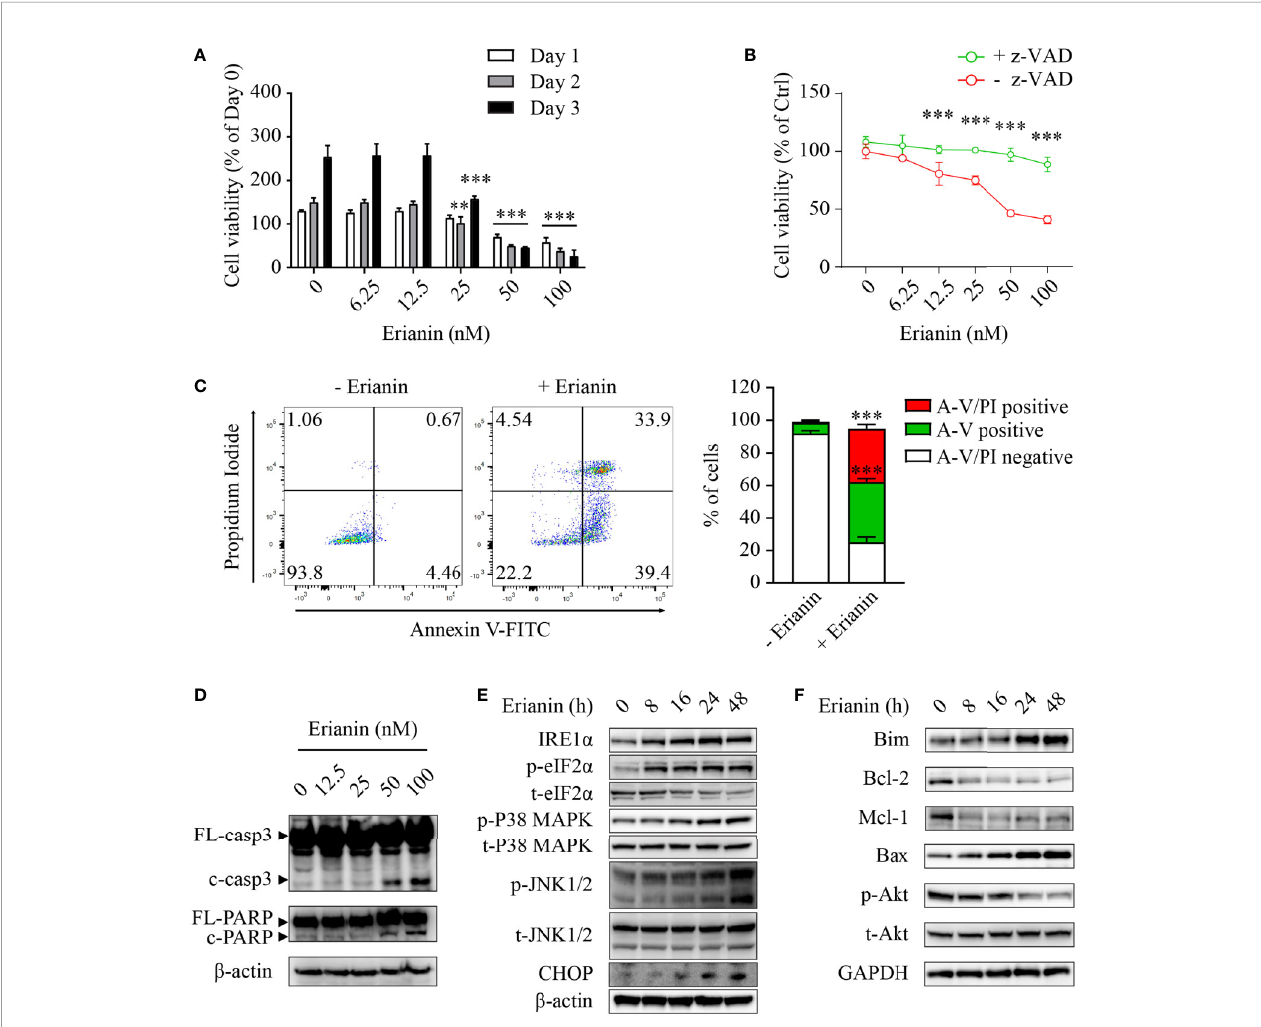
FIGURE 2 | Erianin induces ER stress-associated apoptosis in LNCaP cells. (A, B) LNCaP cell viability was determined by MTS colorimetric assay. LNCaP cells were treated with erianin at indicated concentrations for 1, 2 and 3 days (A) . LNCaP cells were treated with erianin at indicated concentrations in the presence or absence of pan-caspase inhibitor z-VAD at 50 µM for 24 h (B) . Data are shown as a percentage of untreated control at day 0. (C) LNCaP cells were treated with erianin at 100 nM for 24 h and apoptosis was analyzed by fl ow cytometry with propidium iodide (PI) and annexin V-FITC (A-V) co-staining. A-V single positive population represents early apoptotic cells, while A-V and PI double-positive population refers to late apoptotic/dead cells. (D – F) LNCap cells were treated with erianin at indicated concentrations for 24 h (D) or at 50 nM for indicated times (E, F) . Apoptosis (D) , ER stress (E) and Bcl-2 family members (F) were examined by Western blotting. FL-, full length; c-, cleaved; casp3, caspase 3. Data are expressed as mean ± SD. n=3. ** p < 0.01; *** p < 0.001, versus untreated